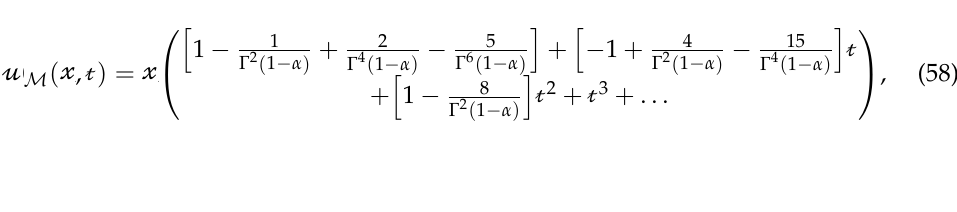
Figure 1. The graphs of the exact solutions among different values of 𝓉 , 𝛼 for the exact solution of Equation (45), exact solution of Equation (48), exact solution of Equation (50), exact solution of Equation (52) and the exact solution of Equations (45), (48), (50) and (52) at 𝛼 = 1 .